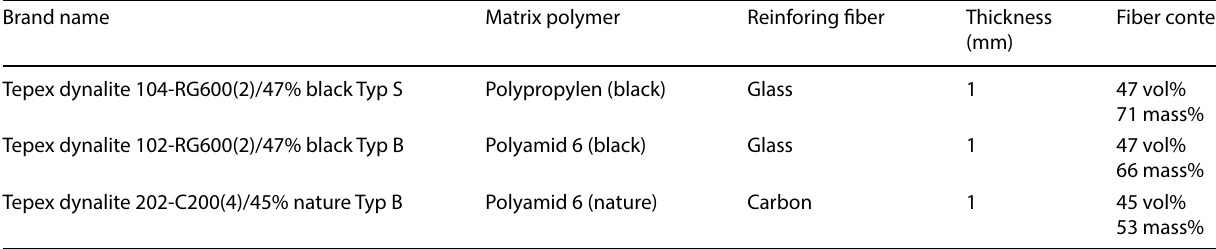
Table 1 Continuous fiber reinforced thermoplastic materials used for the experiments and material tests Brand